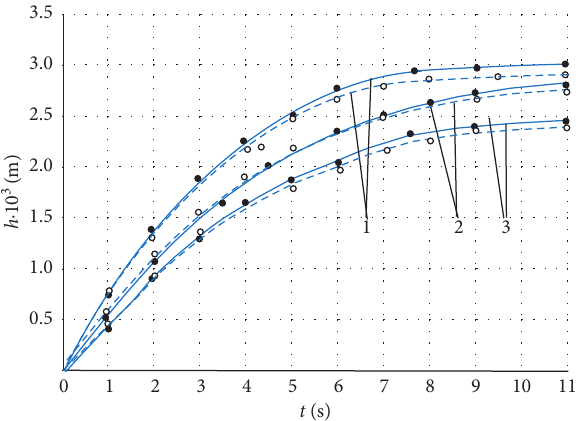
Figure 10: The characteristic kinetic curves of the longitudinal “free” impregnation of the organic fiber bundle of the SVM by EC brand ED-20 at a temperature of 40 ° C and with variable tension forces N t per OFF thread (tension values N t are shown in curves): 1 − N � 0.05N/m; 2 − N � 0.20 N/m; 3 − N � 0.3N/m; ( ● )–theoret- ical curve constructed by equation (9); ( ○ )–experimental values; t